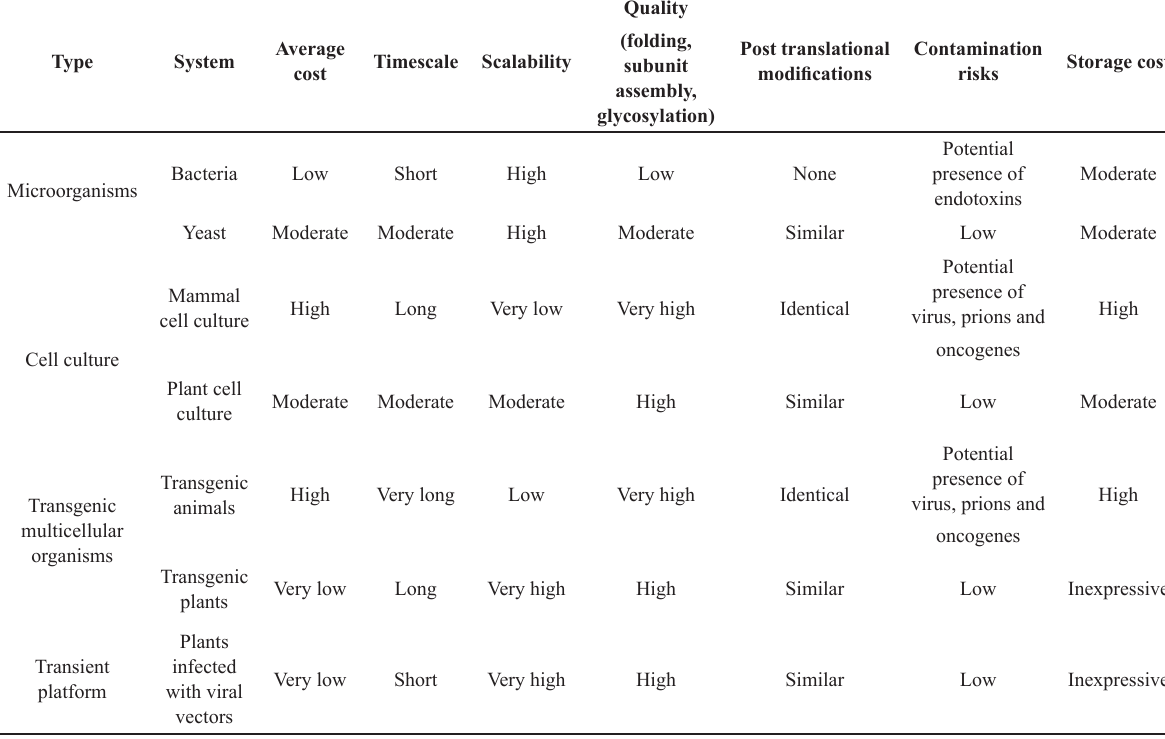
Comparison between different production systems of heterologous proteins of pharmaceutical